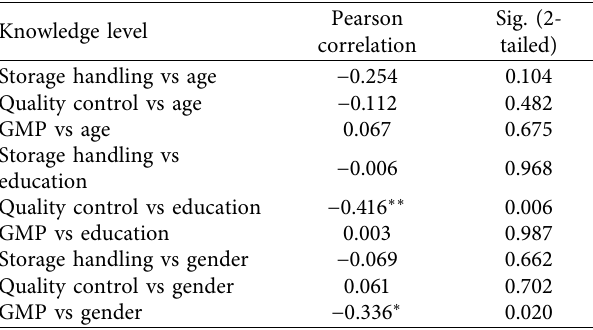
Table 7: Effects of respondents’ demographic characteristics on their food safety